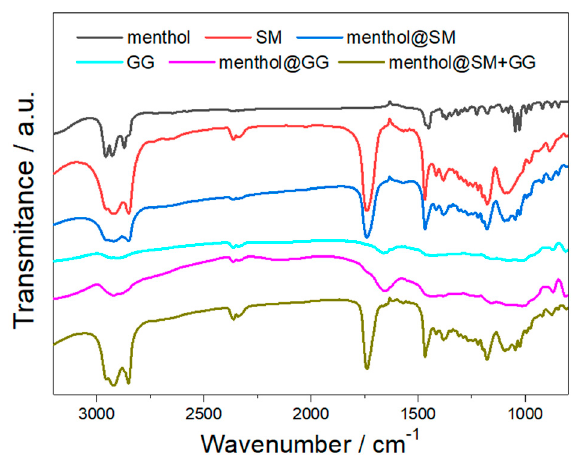
Figure 2. FTIR spectra of menthol, sorbitan monostearate (SM), guar gum (GG), menthol-SM, menthol-GG, and menthol-SM + GG.